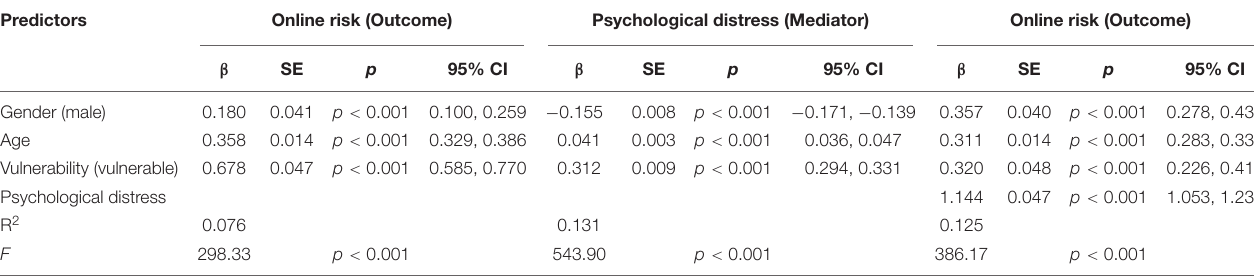
TABLE 3 | Mediation analysis showing the direct and indirect (through mediator) effects of vulnerability on total online risk encounters. Predictors